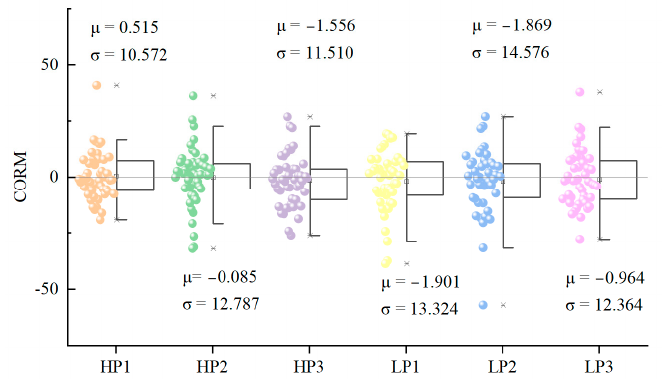
Figure 5. The sequence of the first and second viewings. Note: This description explains the meaning of the scope of “CORM”: when CORM > 0, the first viewing precedes the second viewing; when CORM = 0, they are basically synchronized; and when CORM < 0, the first viewing starts slower than the second one. The analysis and graphics software is Origin Pro 2021 v9.8.0.200. This figure was created by the author.